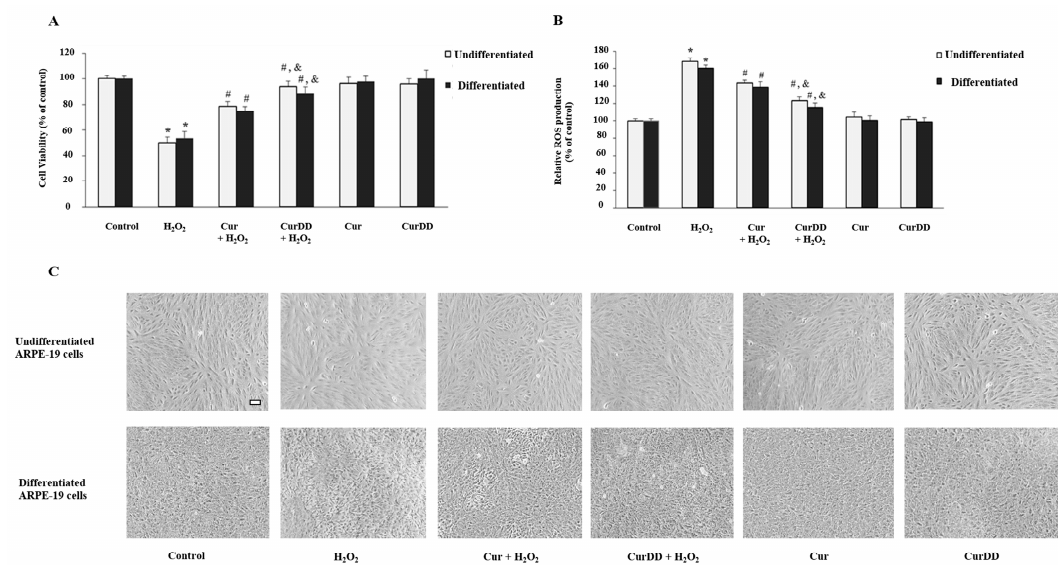
Figure 4. Protective effects of Cur and CurDD against H 2 O 2 -induced ROS production and cytotoxicity in ARPE-19 cells. ( A ) ARPE-19 cells were pre-treated with 10 µM of Cur or CurDD for 24 hours, followed by H 2 O 2 treatment at appropriate concentrations (400 and 200 µM for undifferentiated and differentiate cells, respectively) for 6 hours. Cell viability was measured using MTT assay; ( B ) ROS generation was determined by DCFH-DA assay. Graphs represent average cell viability (mean ± SD values, n = 4; One-Way ANOVA test, * p ≤ 0.05 vs. control group, # p ≤ 0.05 vs. H 2 O 2 group, and & p ≤ 0.05 vs. Cur + H 2 O 2 group); ( C ) Morphology by phase contrast microscopy of undifferentiated ARPE-19 and differentiated ARPE-19 cells under all experimental conditions. Scale bar represents 100 µm.